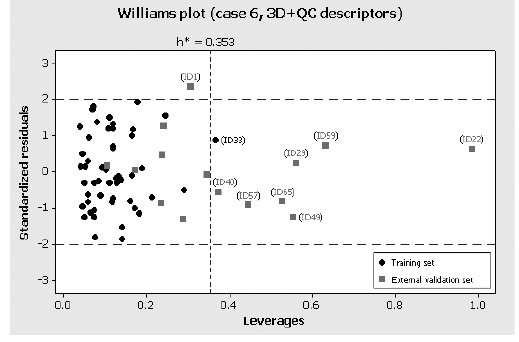
Figure 4. Graphical representation (Williams plot) of the five- descriptor MLR model's applicability domain (AD) together with external validation set